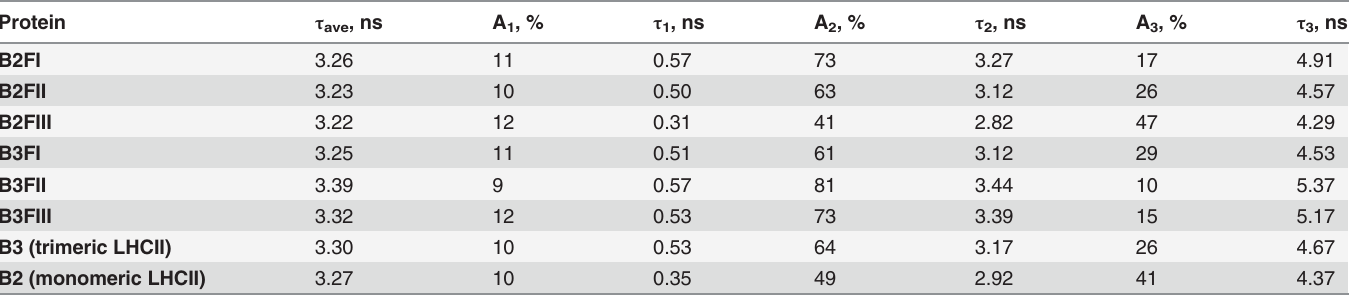
Table 3. Excited state Lifetimes of the LHCBM monomeric and trimeric fractions. Protein τ ave , ns A 1 , % τ 1 , ns A 2 , % τ 2 , ns A 3 , % τ 3 , ns